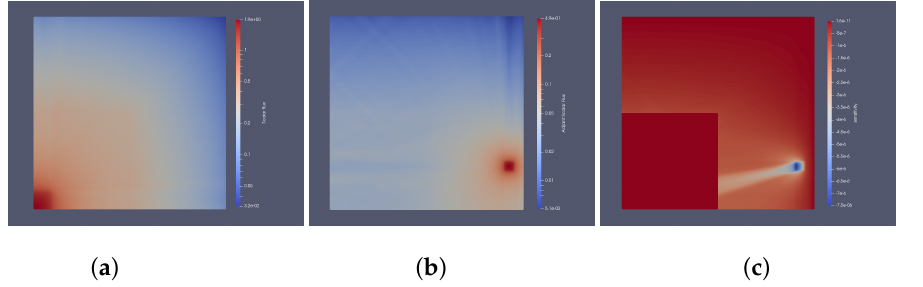
Figure 2. Reference forward ( a ), adjoint solutions, ( b ) and relative response sensitivity with respect to Σ t in region 3 ( c ).